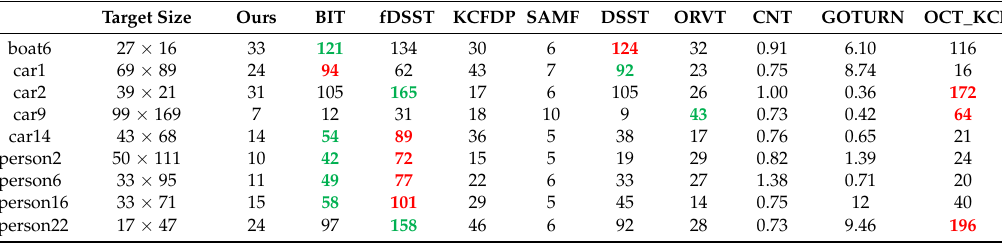
Table 3. Running speed (frame per second) of each tracker on sequences from UAV123 dataset, where the entries in red denote the best results and the ones in green indicate the second best.